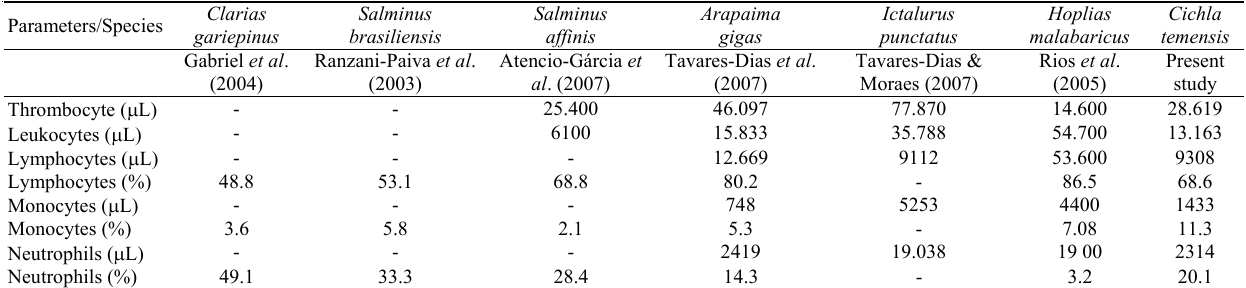
Table 4. Mean values of thrombocyte and leukocyte counts for species of carnivorous fish from literature. - = No